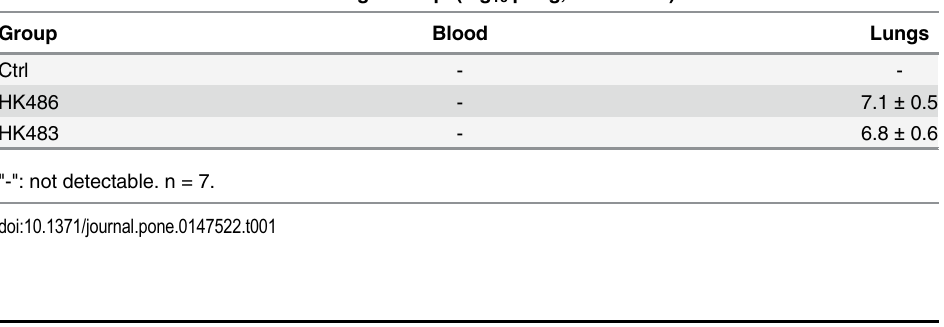
Table 1. Virus titer in the blood and lungs at 3 dpi (log 10 pfu/g, mean ± SD). Group